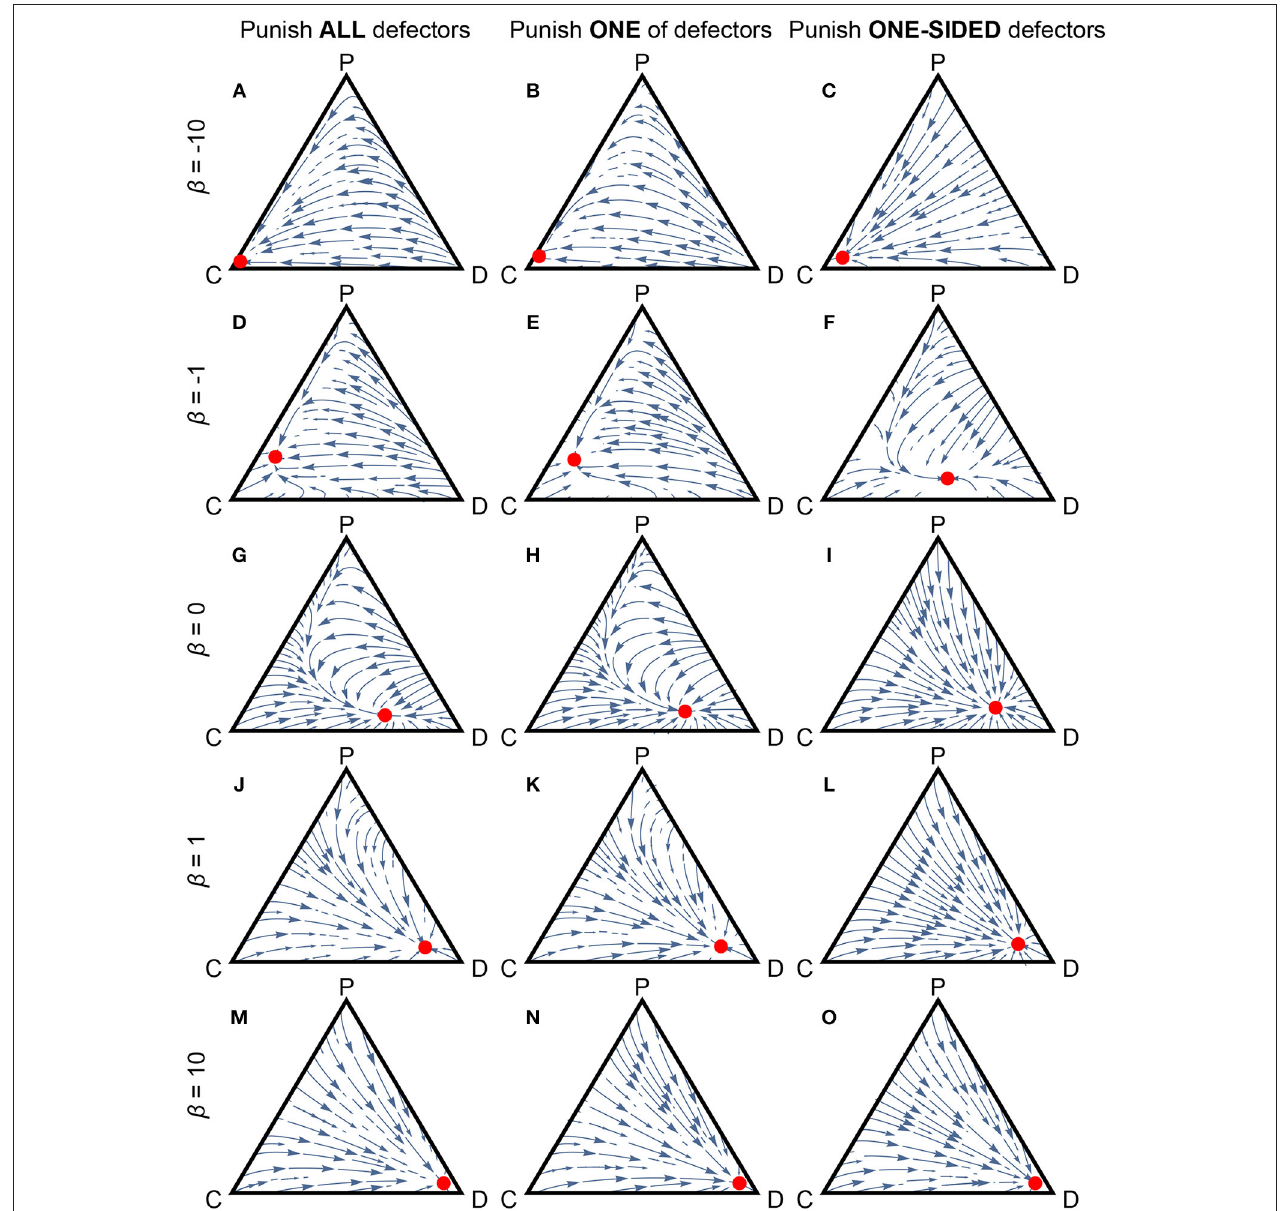
FIGURE 4 | The replicator–mutator dynamics of cooperators (C), defectors (D), and third-party punishers (P). A population is full of one of them at the “C,” “D,” and “P” corners, respectively. Their frequencies are equal at each center of each simplex. Arrows represent trajectories starting from various initial states. Red points represent stable outcomes. (A,D,G,J,M) The ALL variant. (B,E,H,K,N) The ONE variant. (C,F,I,L,O) The ONE-SIDED variant. We set (A–C) β = − 10. (D–F) β = − 1. (G–I) β = 0. (J–L) β = 1. (M–O) β = 10. Parameters: T = 2, F = 3, C = 1, w = 0.1, and µ =